Question: Author a descriptive caption for the visualization shown.
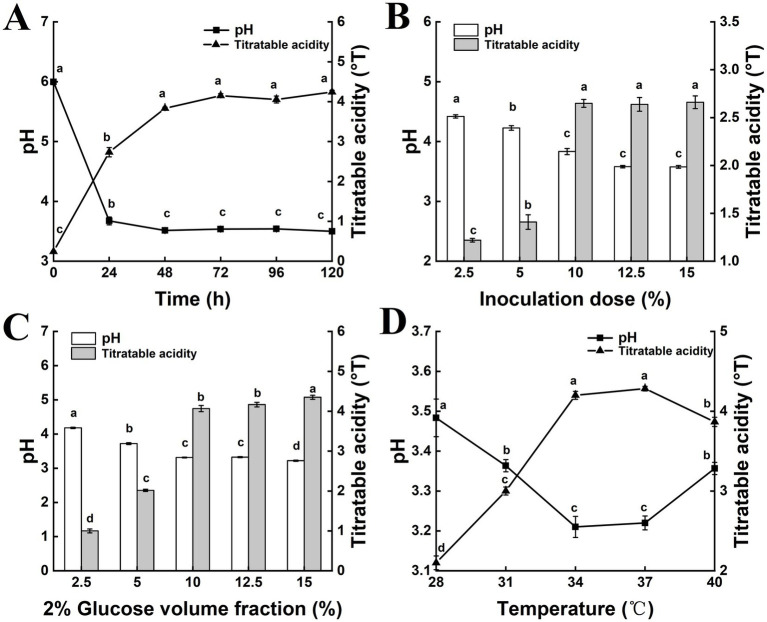
Answer: Optimization of fermentation parameters for sour porridge inoculated with strain GXUN74722. (A) Fermentation time; (B) Inoculation dose; (C) 2% glucose volume fraction; (D) Fermentation temperature (all on pH and titratable acidity).